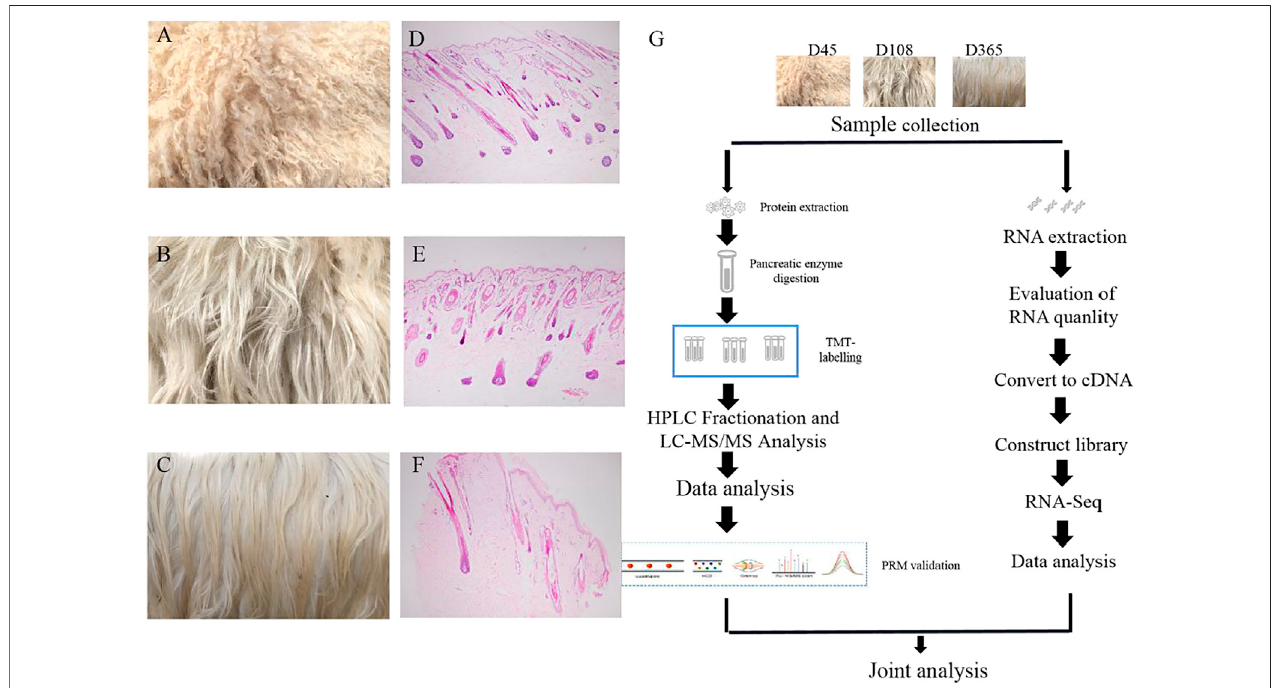
FIGURE1| WoolphenotypeofZhongweigoatandwork fl ow (A) Zhongweigoatwoolatday45. (B) Zhongweigoatwoolatday108. (C) Zhongweigoatwoolatday 365. (D) 45-days-old goat hair follicle. (E) 108-days-old goat hair follicle. (F) 365-days-old goat hair follicle. (G) work fl ow of quantitative proteome and transcriptome analysis of skin using TMT LC-MS/MS and RNA-seq